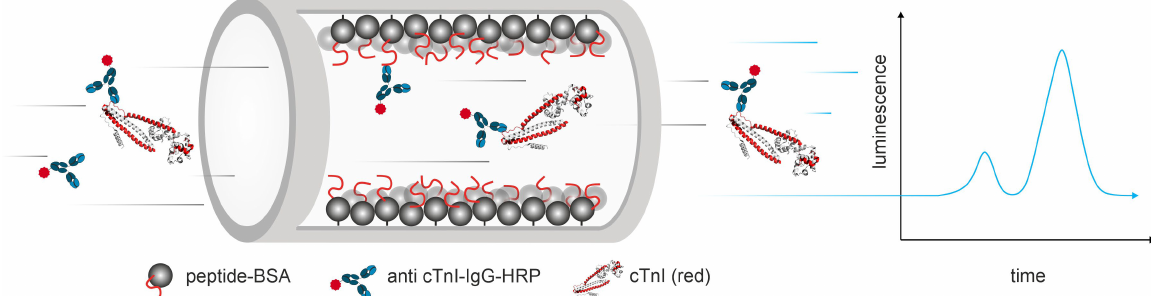
Figure 1. Simplified biosensor principle: The cTnI–antibody–peroxidase conjugate binds to the analyte cTnI (PDB 4Y99) and cannot interact with the peptide-functionalized column (coated with a peptide–BSA conjugate). The intensity of the chemiluminescence produced by the enzyme–substrate reaction is largely proportional to the analyte concentration in the